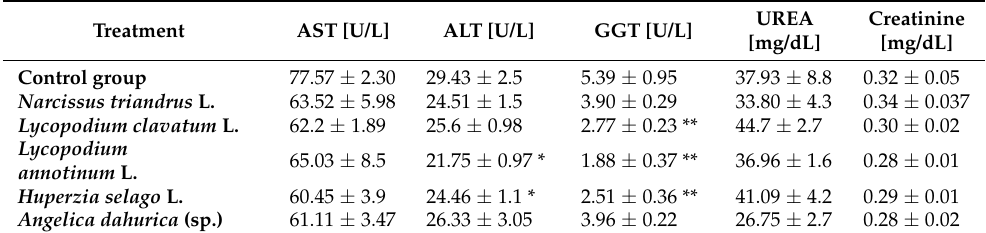
Table 2. The influence of extracts on the AST, ALT and GGT activity and urea and creatinine concentrations. All values are reported as mean ± SEM ( n = 7). Significance: * p < 0.05, ** p < 0.01 vs. control group (one-way ANOVA followed by Tukey’s post hoc